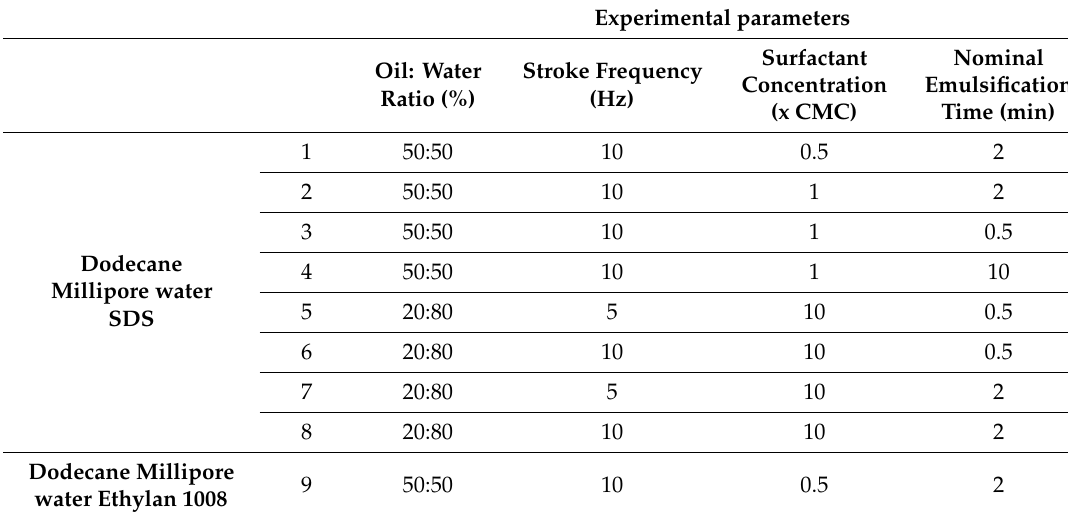
Table 1. Experimental conditions of the experiments with Piston 1.